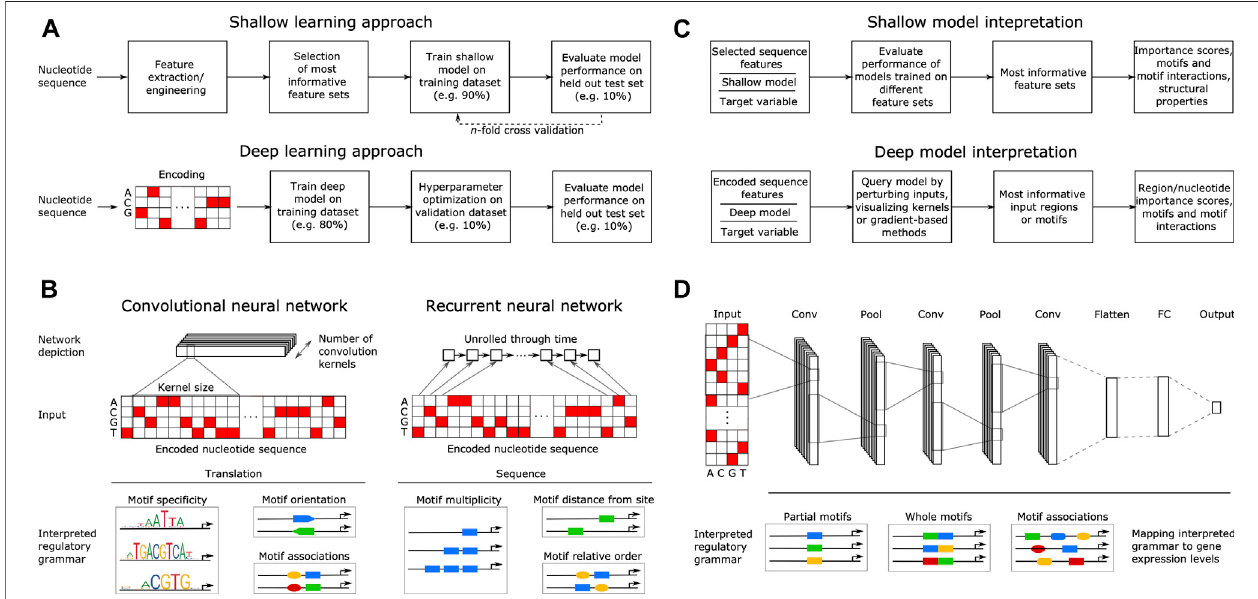
FIGURE 2 | Principles of machine learning from nucleotide sequence. (A) Flowcharts of a typical supervised shallow modeling approach (top) and a typical supervised deep modeling approach (bottom) , depicting a one-hot encoding that equals k-mer embedding with k (cid:1) 1. (B) Overview of convolutional (CNN) and recurrent neural networks (RNN) in interpreting DNA regulatory grammar. A CNN scans a set of motif detectors (kernels) of a speci fi ed size across an encoded input sequence, learning motif properties such as speci fi city, orientation and co-association. An RNN scans the encoded sequence one nucleotide at a time, learning sequential motif properties such as multiplicity, distance from e.g. transcription start site and the relative order of motifs. (C) Interpreting shallow models (top) by evaluating their performance when trained on different feature sets can yield feature importance scores, motifs and motif interactions, as well as compositional and structural properties. Similarly, interpreting the regulatory grammar learned by deep models (bottom) , by e.g. perturbing the input, visualizing kernels or using gradient- basedmethods,canyieldfeatureimportancescoresspanningnucleotidesuptowholeregions,aswellasmotifsandmotifinteractions. (D) Exampleofatypicaldeepneural network (DNN) comprising three separateconvolutional layers (Conv)connected via pooling layers(Pool)and a fi nalfully connectednetwork (FC) producingthe outputgene expression levels. Pool stages compute the maximum or average of each motif detector ’ s recti fi ed response across the sequence, where maximizing helps to identify the presenceoflongermotifsandaveraginghelpstoidentifycumulativeeffectsofshortmotifs.TheDNNlearnsdistributedmotifrepresentationsintheinitialConvlayersandmotif associations that have a joint effect on predicting the target in the fi nal Conv layer, representing DNA regulatory grammar that is mapped to gene expression